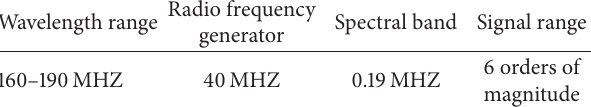
Table 2: ICP-AES instrument